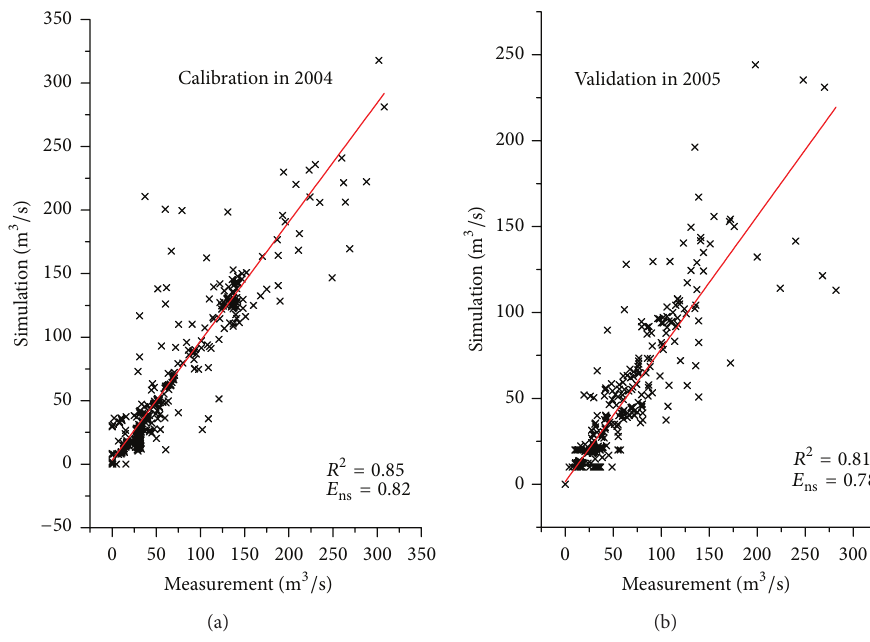
Figure 3: The calibration and validation on streamflow of the SWAT.